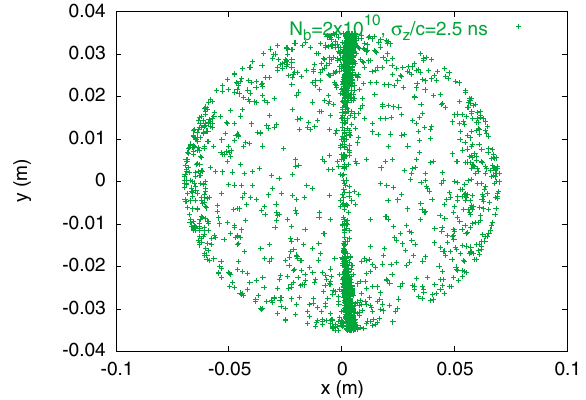
FIG. 6. (Color) Transverse electron distribution in a PS com- bined function magnet for N 2 : 5 ns , after about 2 (cid:16) s (passage of 72 bunches).